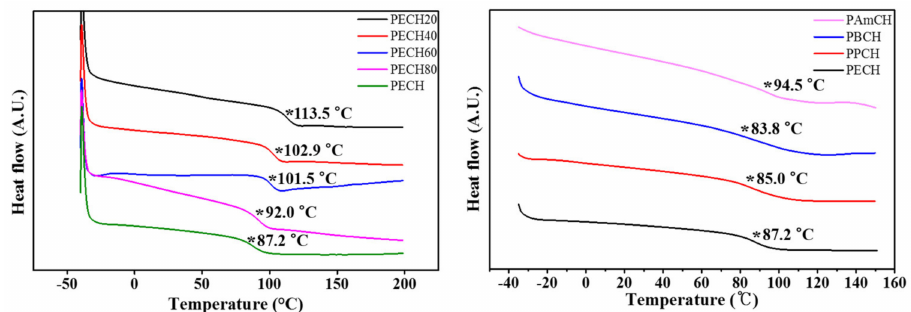
Figure 3. Differential scanning calorimetry (DSC) thermogram of PECH# (PECH20, PECH40, PECH60, and PECH80) and PACH (PECH, PPCH, PBCH, and PAmCH) (* indicates the glass